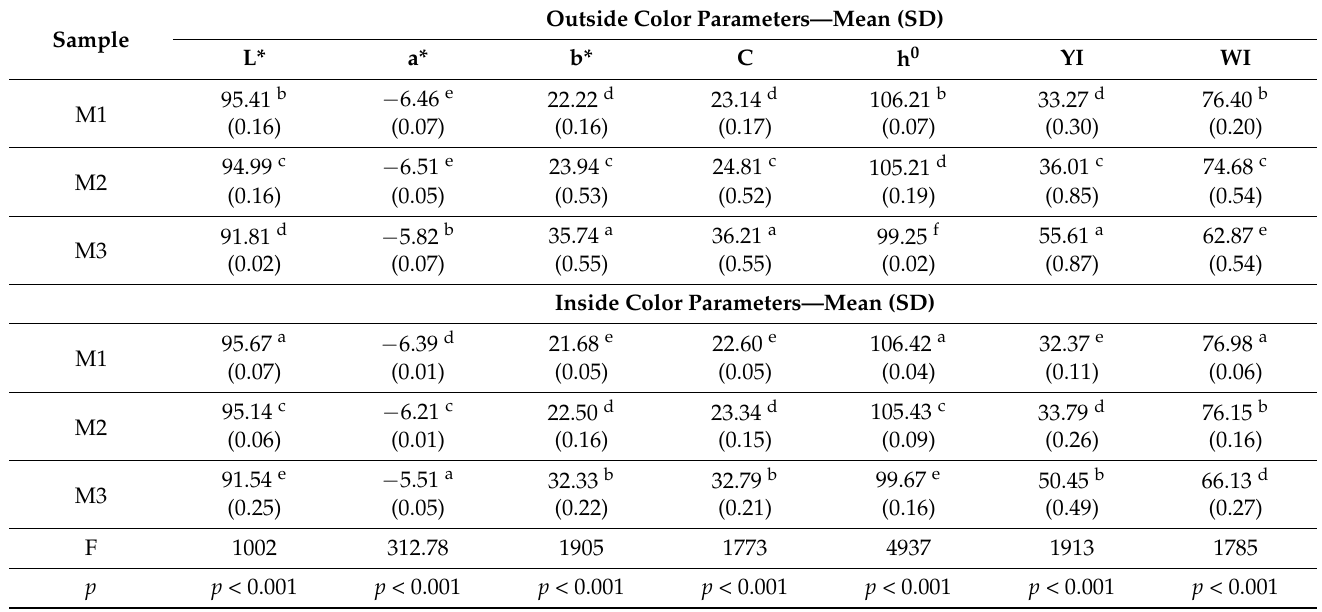
Table 1. The CIE L*a*b* color parameters of margarine